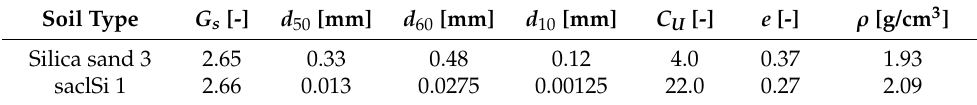
Table 1. Parameters of the tested soil